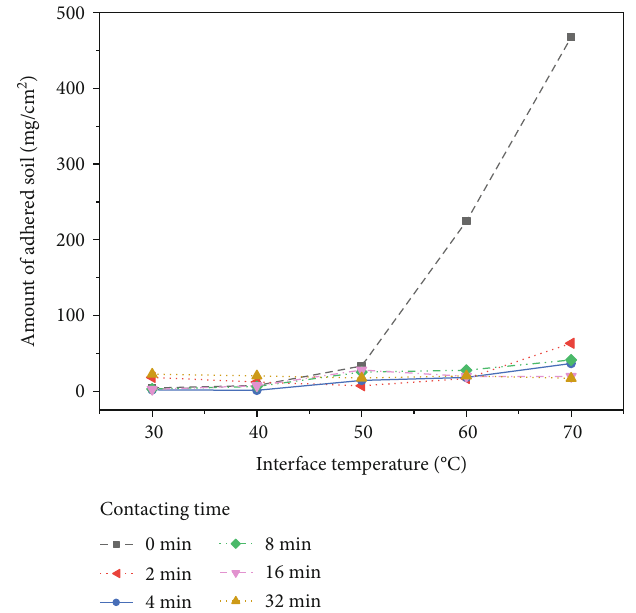
Figure 12: The relationship between the interface temperature and the amount of adhered soil.